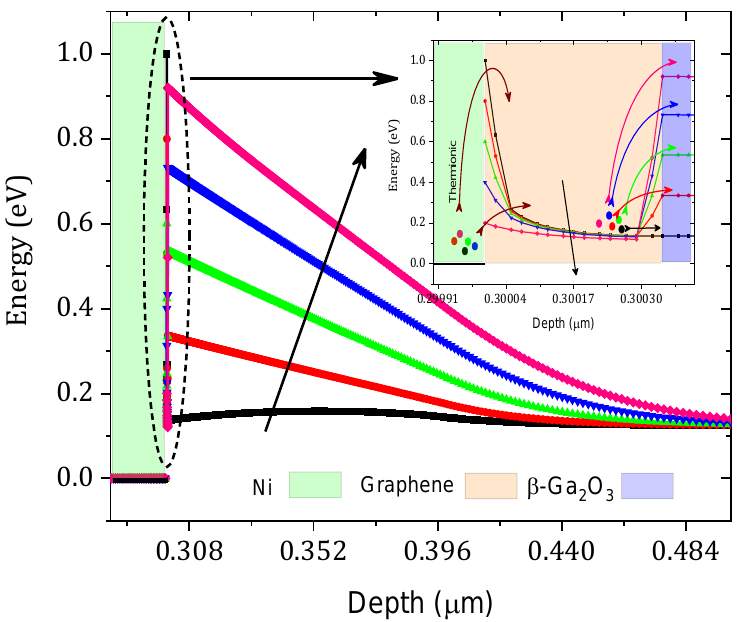
Figure 11. Variation in the equilibrium conduction band with the graphene workfunction. The inset is a zoomed Ni/graphene/ β -Ga 2 O 3 interface conduction band.